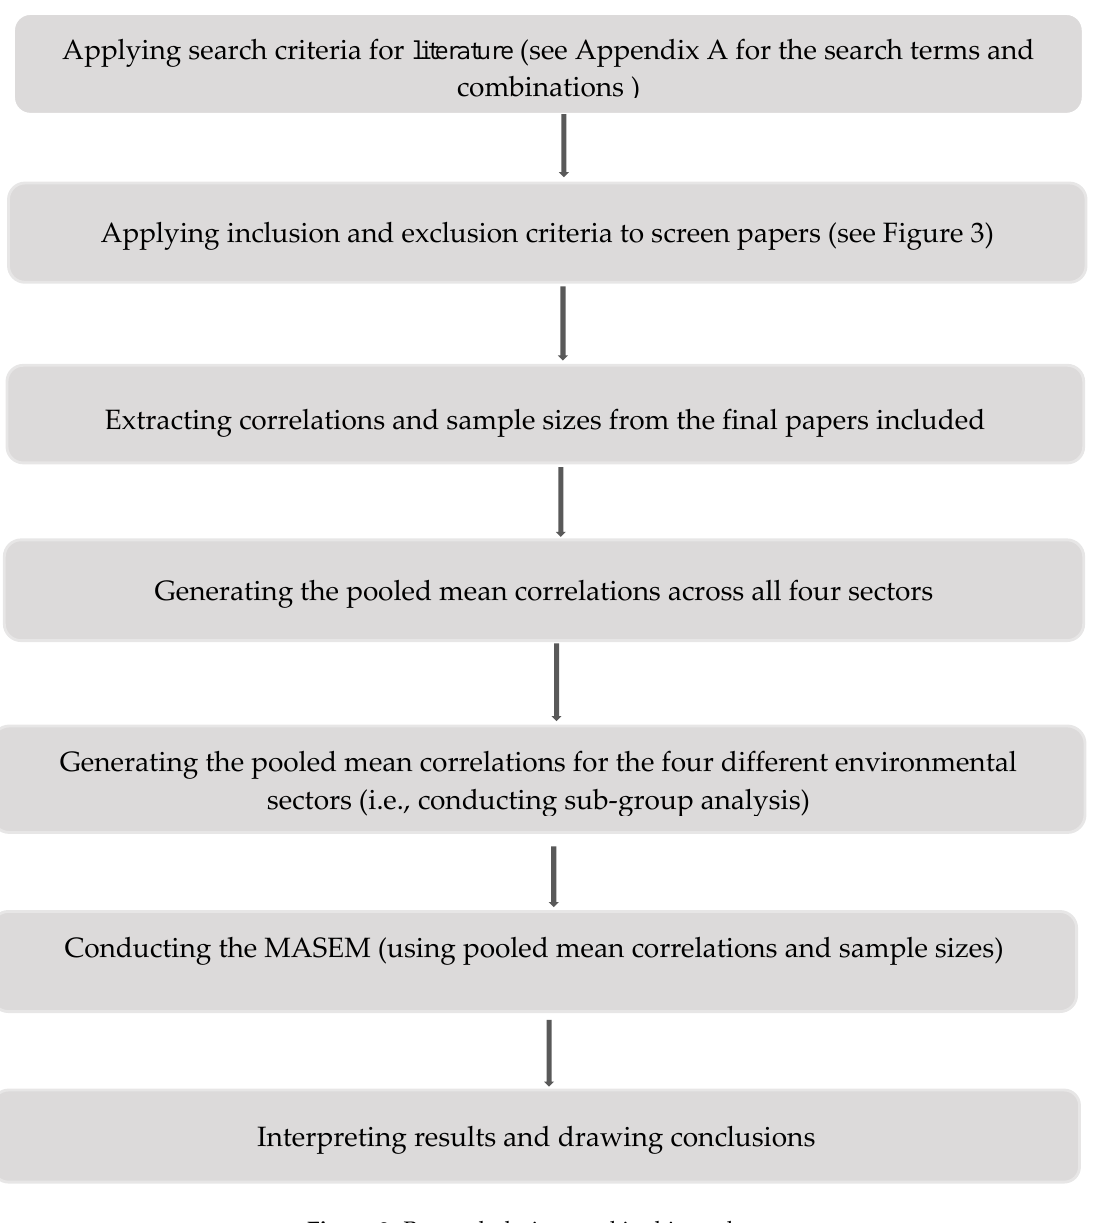
Figure 2. Research design used in this study.